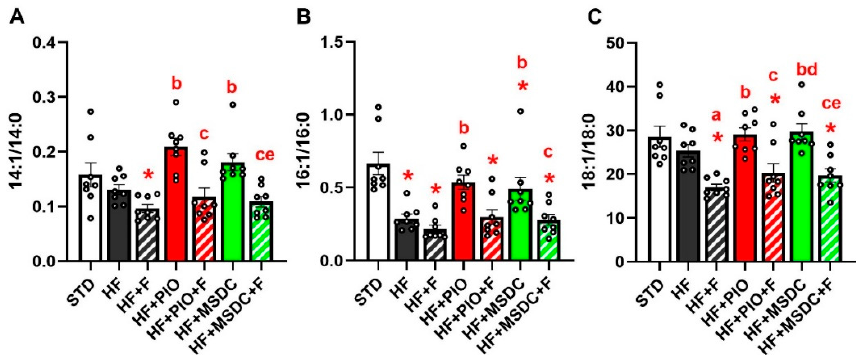
Figure 6. FA desaturation index in TAG. The ratios of the product of the desaturation and of the parent FA were calculated for myristic vs. myristoleic acid (14:1 / 14:0; A ), palmitic vs. palmitoleic acid (16:1 / 16:0; B ) and stearic vs. oleic acid (18:1 / 18:0; C ). Data are means ± SEMs ( n = 8). * Significantly di ff erent from STD ( p ≤ 0.05, t -test). a—significantly di ff erent vs. HF; b—significantly di ff erent vs. HF + F; c—significantly di ff erent vs. HF + PIO; d—significantly di ff erent vs. HF + PIO +